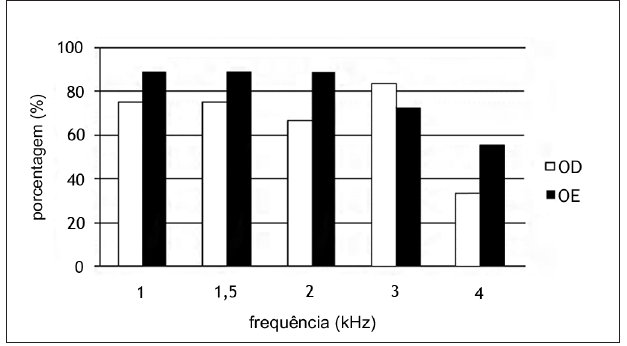
Figura 1. Ocorrência de EOATs por faixa de frequência em indivíduos normo-ouvintes com queixas de zumbido e hiperacusia. OD - orelha direita. OE - orelha